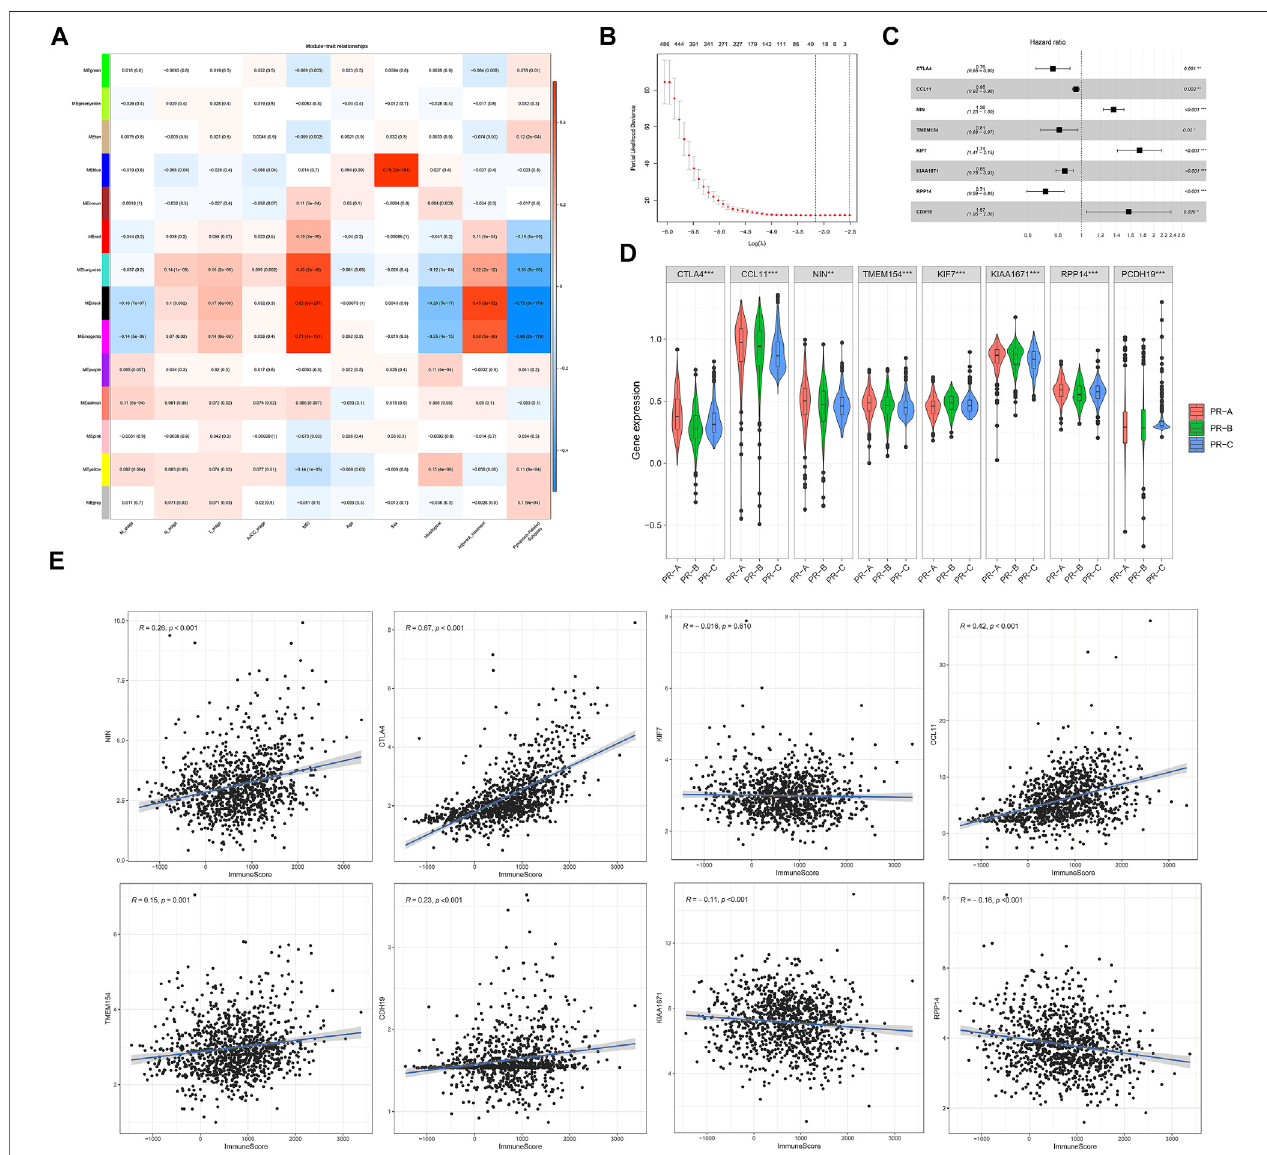
FIGURE 4 | Generation of risk assessment tool-constructions to predict patient survival related to pyroptosis-related regulators for colon cancer patients. (A) Identi fi cation of a co-expression module in colon cancer. Each piece of the leaves on the cluster dendrogram corresponded to a gene, and those genes with similar expression patterns compose a branch. Correlation between gene modules and clinical features or three pyroptosis-related (PR) clusters. The upper row in each cell indicatesthecorrelationcoef fi cientrangingfrom − 1to1ofthecorrelationbetweenacertaingenemoduleandclinicalfeaturesorthreePRclusters.Thelowerrowin each cell indicates the p -value. (B) In the LASSO-Cox model of inner-training cohort from GSE39582, GSE33113, and The Cancer Genome Atlas — Colon Adenocarcinoma (TCGA-COAD) data, the minimum standard was adopted to obtain the value of the super parameter l by 10-fold cross validation. (C) Hazard ratio and p -valueoftheconstituentsinvolvedinmultivariateCoxregressionanalysesofeightsignaturesininner-trainingcohorts. (D) TheexpressionofeightsignaturesinthreePR clusters: PR-A, red; PR-B, green; and PR-C, blue. The upper and lower ends of the boxes represent the interquartile range of values. The lines in the boxes represent median value, and black dots show outliers. The asterisks represent the statistical p -value. ANOVA test. * p < 0.05; ** p < 0.01; *** p < 0.001; p ≥ 0.05, not signi fi cant. (E) The association between the immuneScores calculated with ESTIMATE and the expression of eight signatures related to three PR clusters.